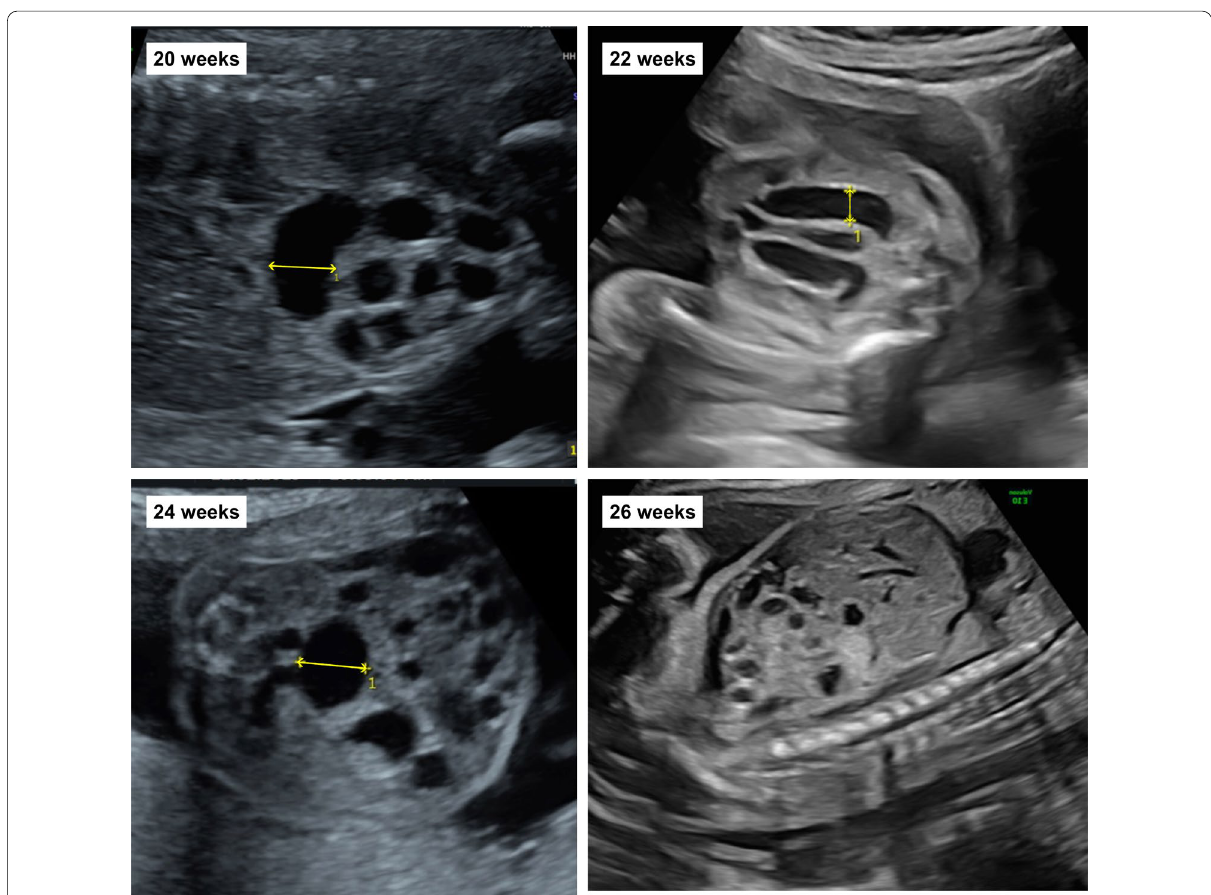
Fig. 1 Grayscale serial foetal morphology ultrasound scan images. 20 weeks of gestation: dilated small bowel (7-10 mm; yellow resonance arrow) and echogenicity within the bowel tissue. 22 weeks of gestation: persistent yet non-progressive small bowel dilation (8-10 mm). Overall stable foetal interval growth, foetal movements, and amniotic fluid index. 24 weeks of gestation: increase in small bowel dilation to 12 mm with mild oedema of the bowel tissue. 26 weeks of gestation: significant and acute reduction in small bowel dilation to 2-3 mm. There is no obvious peristalsis in the proximal gastrointestinal tract but echo-free fluid streaming within the bowel lumen is visualised. The stomach is normal with no